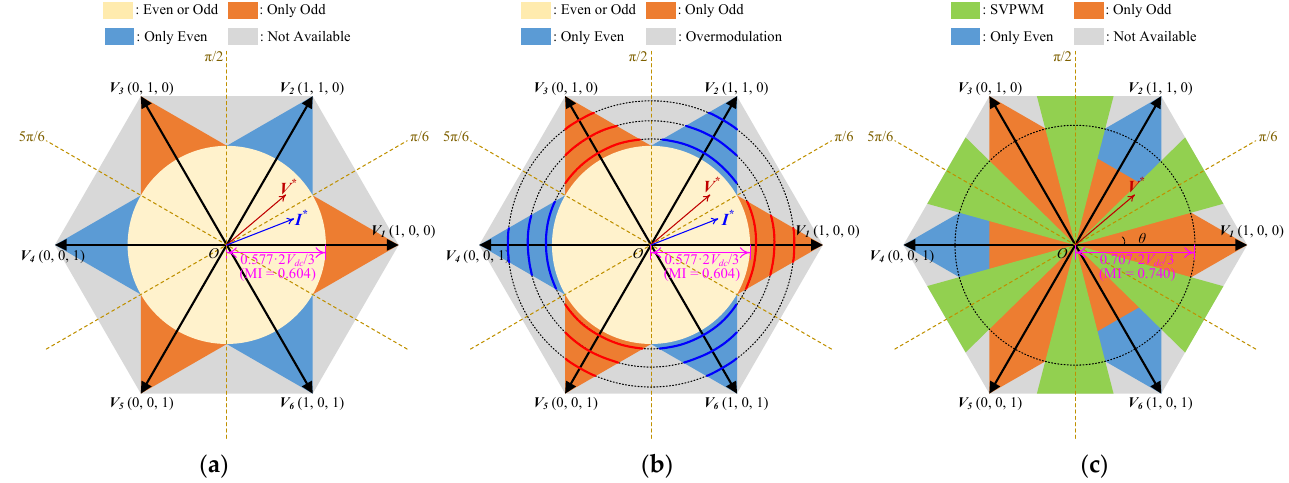
Figure 2. Conventional CMC reduction methods: ( a ) MRSPWM; ( b ) MRSPWM with over- modulation method; ( c ) HMSPWM.